Question: Which kind of chart has been used to present this data?
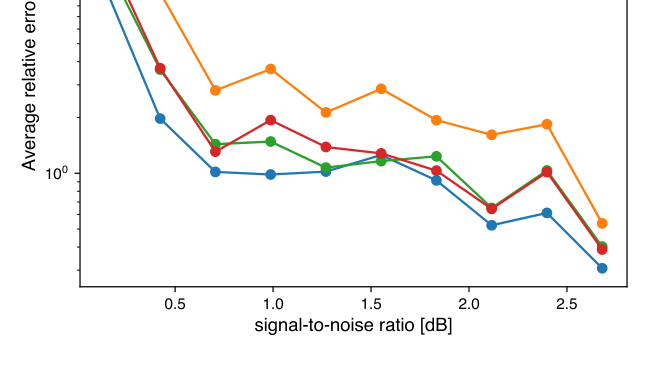
Answer: line